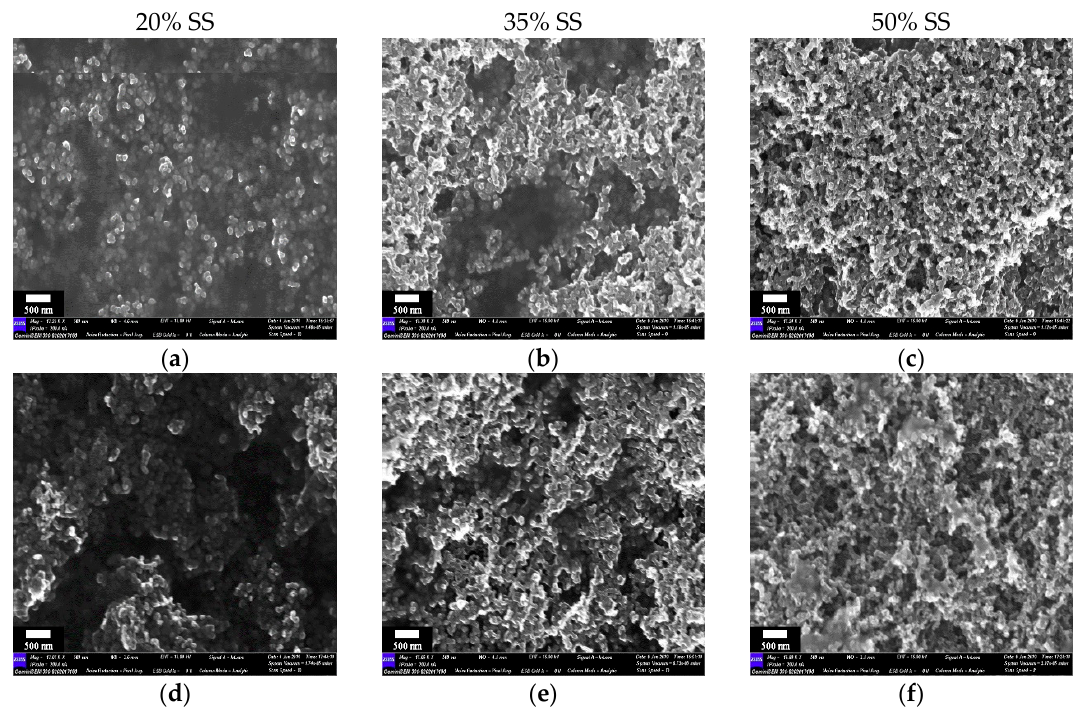
Figure 5. Effects of carbon black content on SEM of cured BCC films (SS-CMC/SBR: ( a )–( c ); SS-SA: ( d )–( f